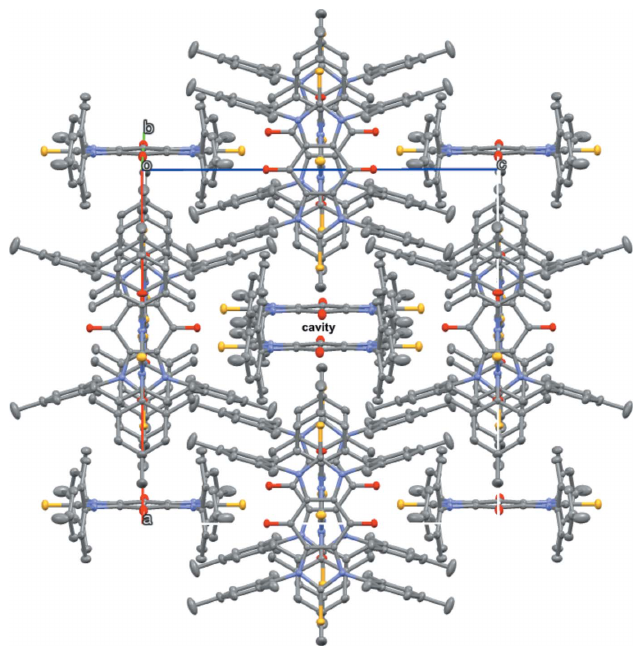
Figure 2 A three-dimensional packing diagram of the title compound viewed along the b axis.